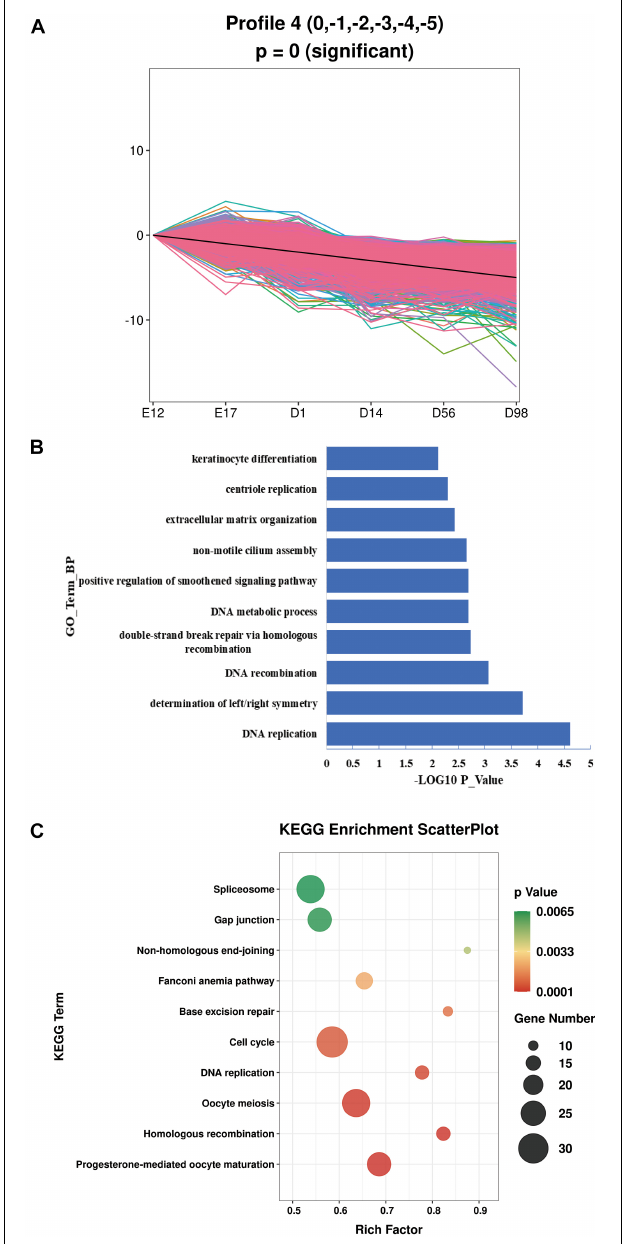
FIGURE 2 | The GO enrichment and KEGG pathway analysis of profile 4. (A) Details of profile 4. (B) The top 10 biological processes in profile 4. (C) The top 10 KEGG pathways in profile 4.